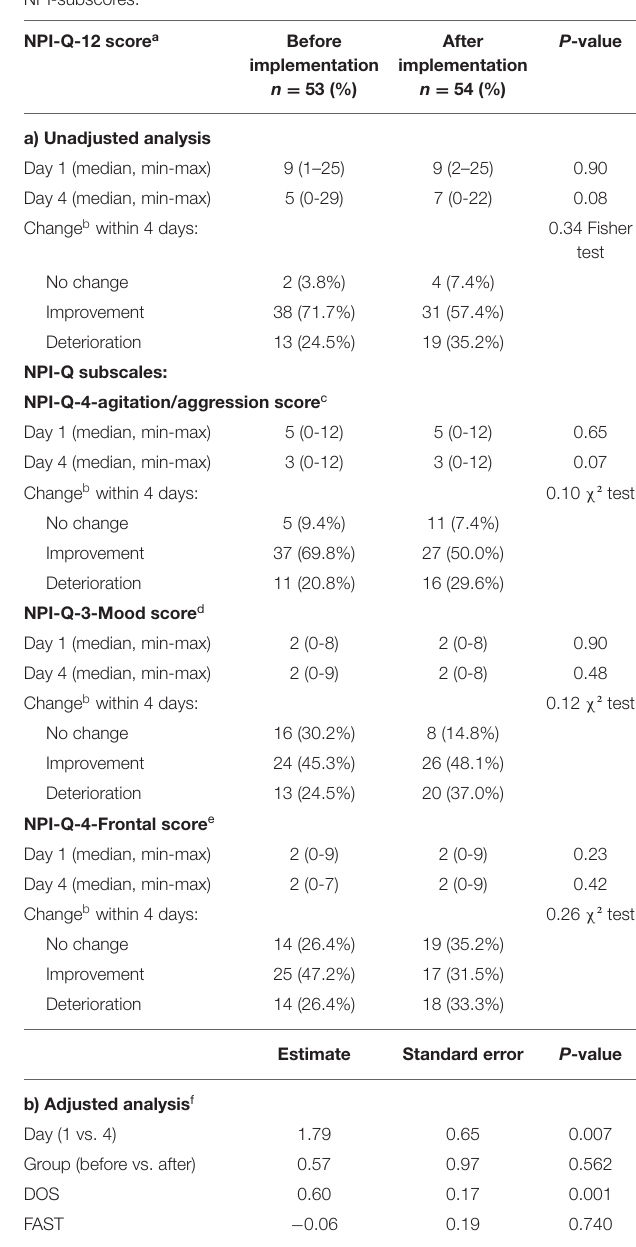
TABLE 1 | Characteristics of the study population before and after STI implementation.